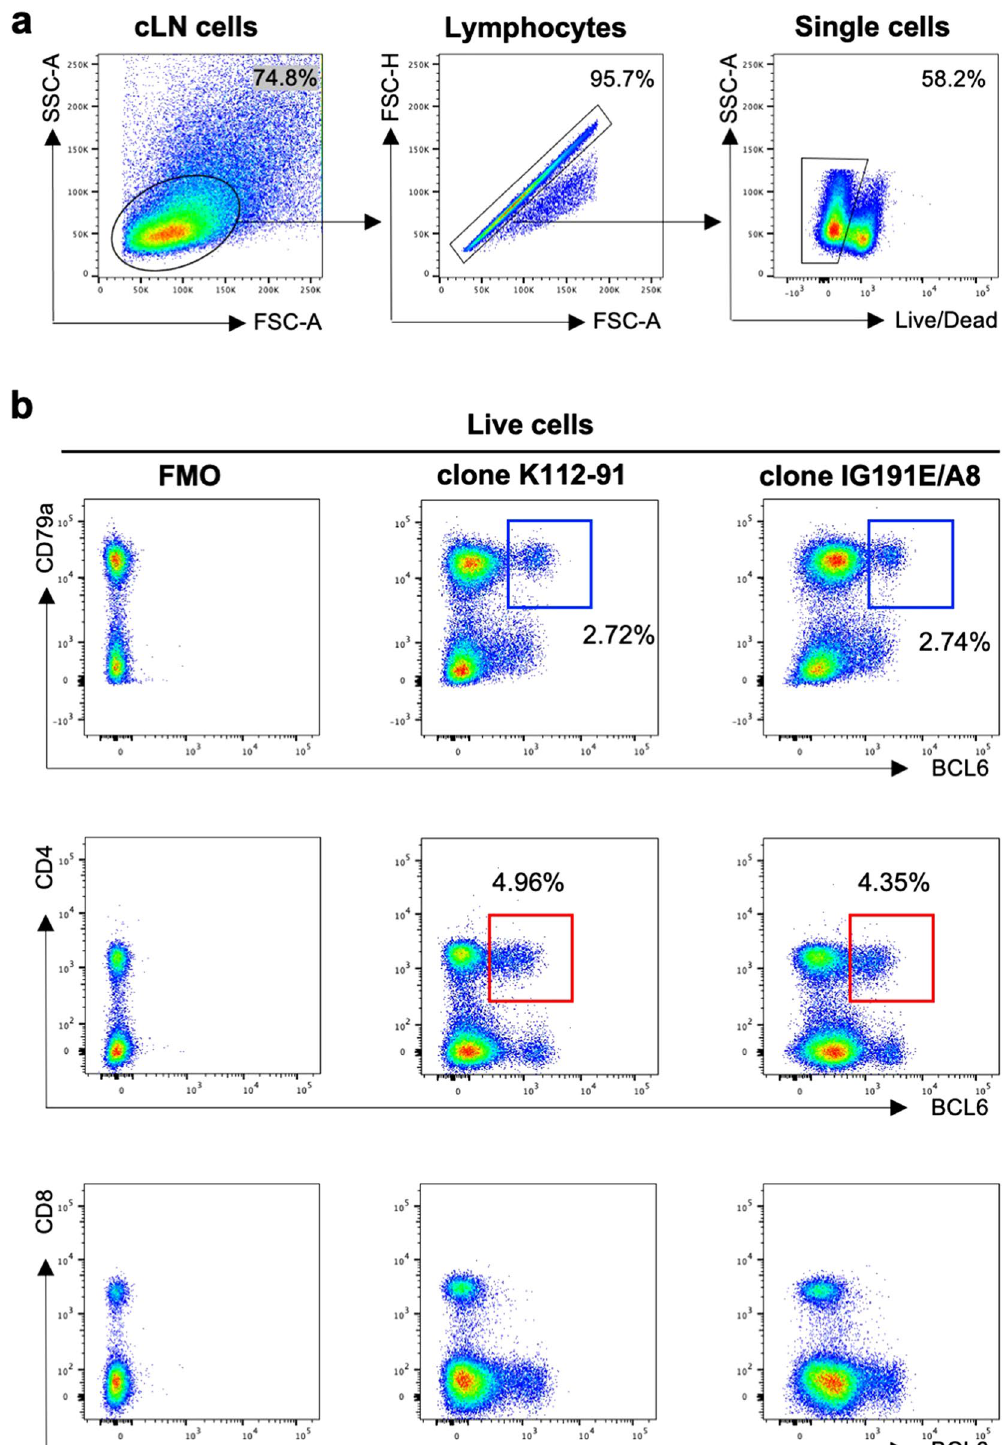
Figure 1. Cross-reactivity of commercial anti-human/mouse BCL6 antibodies with lymph node cells from influenza infected ferret. ( a ) Gating strategy to identify live lymphocytes in the ferret LN. Lymphocytes were identified by forward scatter area (FSC-A) and side-scatter area (SSC-A). Doublets were excluded by gating on single cells as determined by FSC-A versus FSC-H, and live cells were identified by viability dye exclusion. For each step, the parental population is indicated above the plot. ( b ) Representative plots of influenza-infected ferret lymph node cells stained with anti-BCL 6 (clone K112-91 and clone IG191E/A8), CD79a, CD4 and CD8 antibodies. The parental population is indicated above the plot. Blue box indicates GC B cells (BCL6+CD79a+) and red box indicates Tfh cells